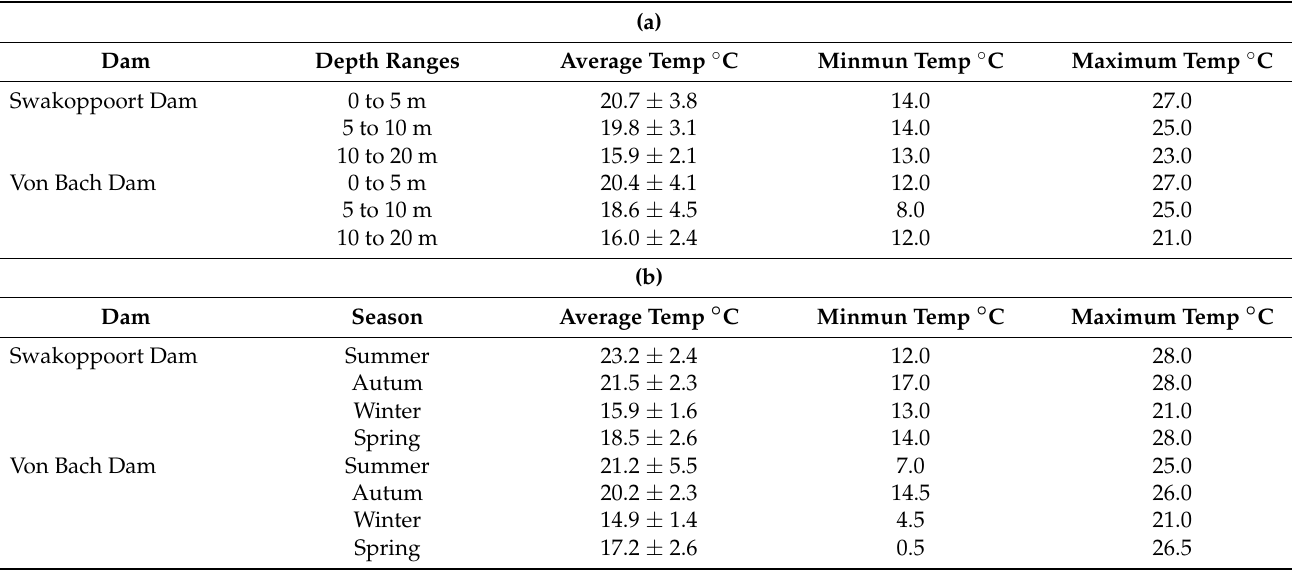
Table 2. The average ± standard deviation of water column temperature in the Swakoppoort and Von Bach dams during the study period (2003–2019) at (a) different depth ranges and (b) among